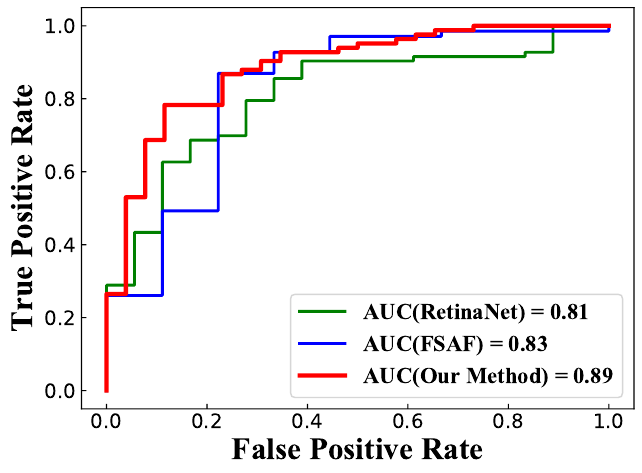
Figure 9. Comparison of the detection performance of the proposed method under different thresh- olds for matching degree.